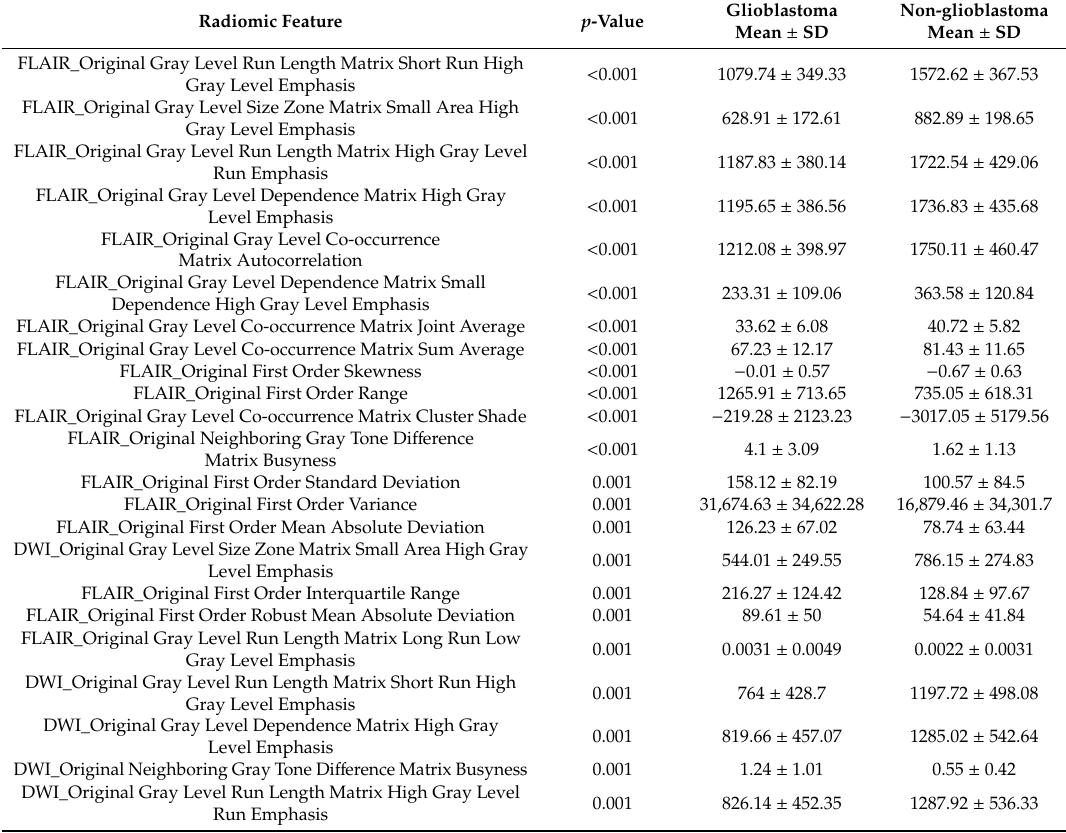
Table A2. DWI and FLAIR Radiomic Features with Significant Di ff erence by Wilcoxon Rank Sum Test between Glioblastoma and